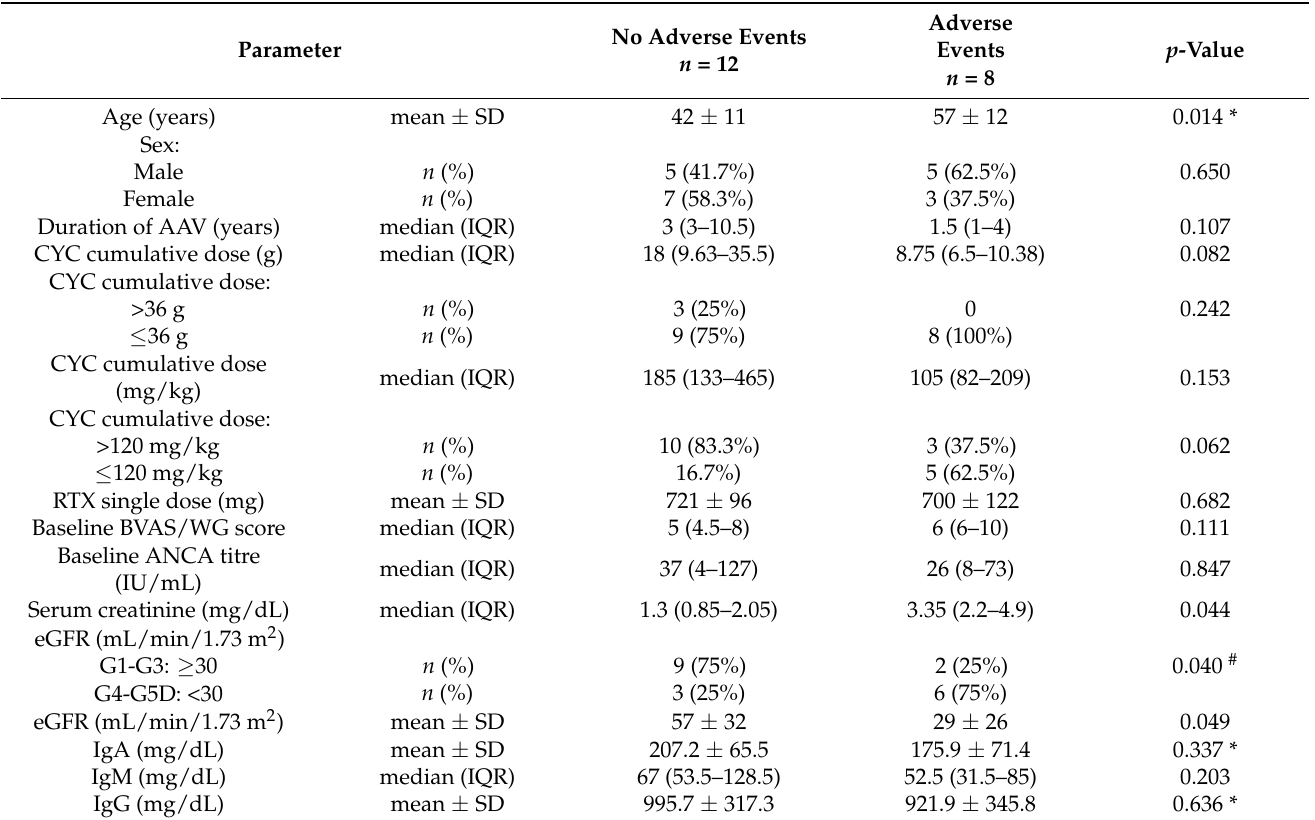
Table 4. Comparison of patients with and without adverse events related to RTX